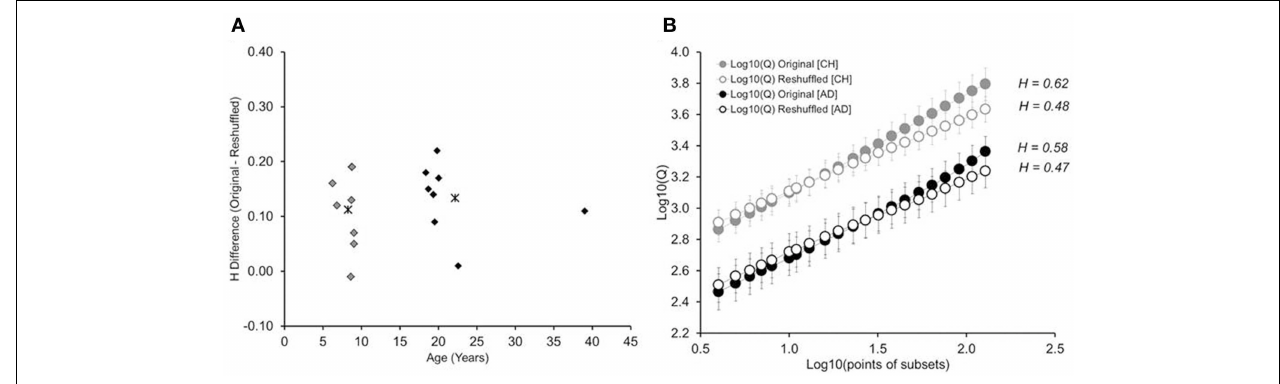
log 10 -log 10 coordinates, separated by age group (children, adults), and type of trial series (original and reshuffled). Error bars represent standard errors of average Qs obtained for the group of eight participants in Experiment 2. CH: children and AD: adults.